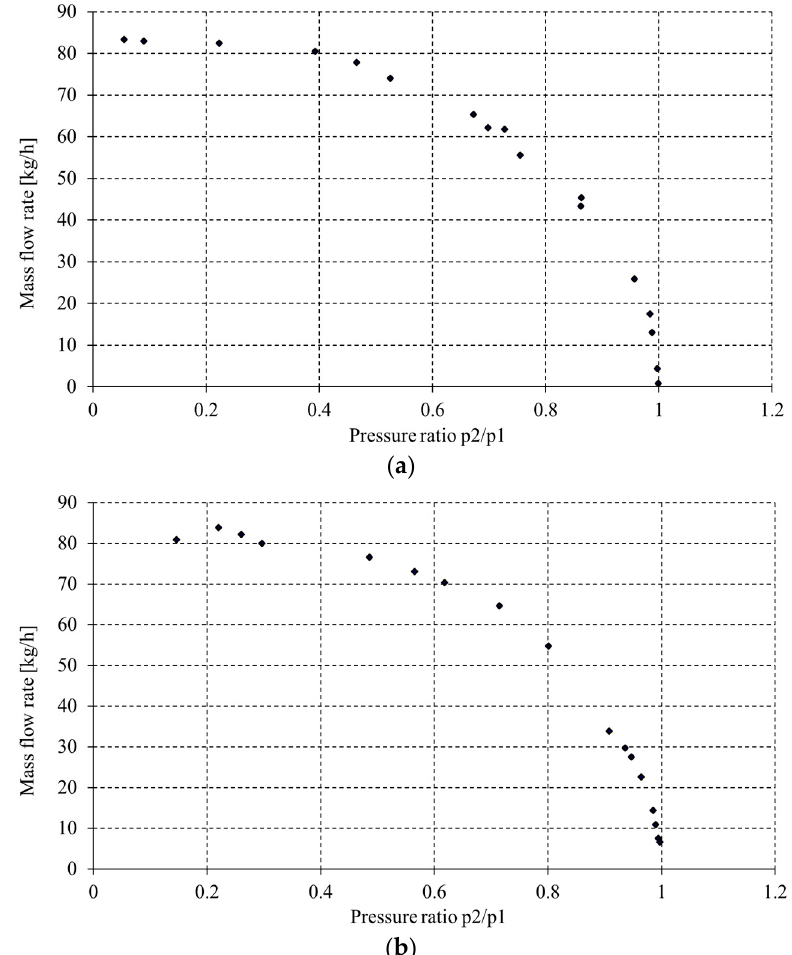
Figure 8. Dependence of mass flow rate on pressure ratio for 5/2 PARKER No. 341NO3 manifold with bored channels (Ø 8 mm), working position: ( a ) currentless, ( b ) with coil energized.